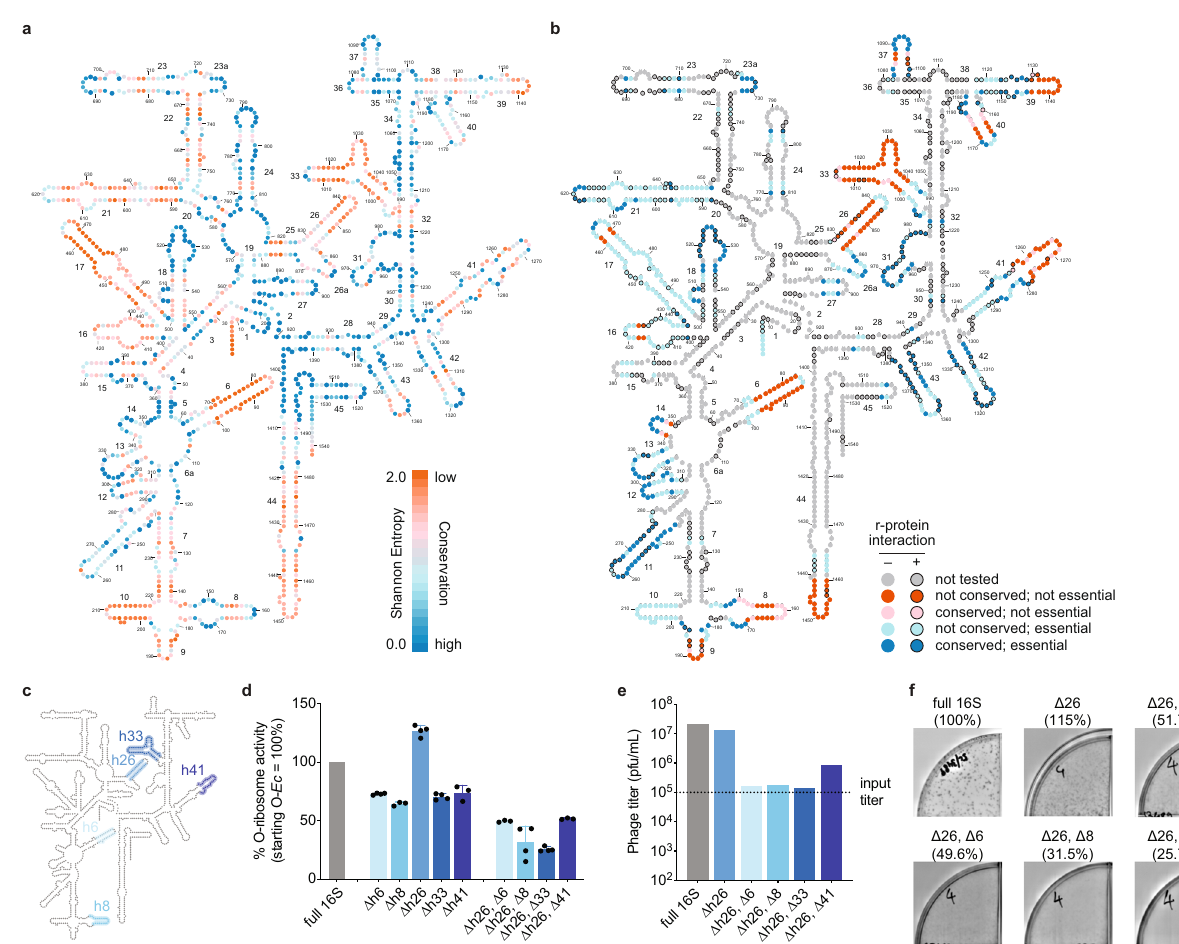
Fig. 2 Establishing EP – SP correspondence via E. coli 16S rRNA truncation analysis. a Nucleotide conservation of the 16S rRNA which was used to guide truncated rRNA studies. Structure generated via Ribovision 60 . b Composite of tested 16S rRNA truncations and binned by their effects on orthogonal sfGFP reporter translation. Variants with sfGFP output below 25% are considered inactive. c Key deletions used in the SP analysis as mapped on the E. coli 16S rRNA secondary structure. d Single and double 16S rRNA truncations variably affect orthogonal GFP reporter translation, providing a gradient of activities for SP-based analyses. Data are normalized to untruncated E. coli 16S o-rRNA. Data re fl ect the mean and standard deviation of 3 – 4 biological replicates ( n = 3-4). e Enrichment assays of SPs encoding full-length and truncated E. coli 16S o-rRNAs. f Plaque assays showing the relationship between 16S o-rRNA activity and plaque formation. Labels indicate the truncation and activity in orthogonal GFP reporter translation relative to the untruncated 16S E. coli o-rRNA. Data re fl ect the mean and standard deviation of 1 – 11 biological replicates ( n = 1 – 11). Source data are available in the Source Data